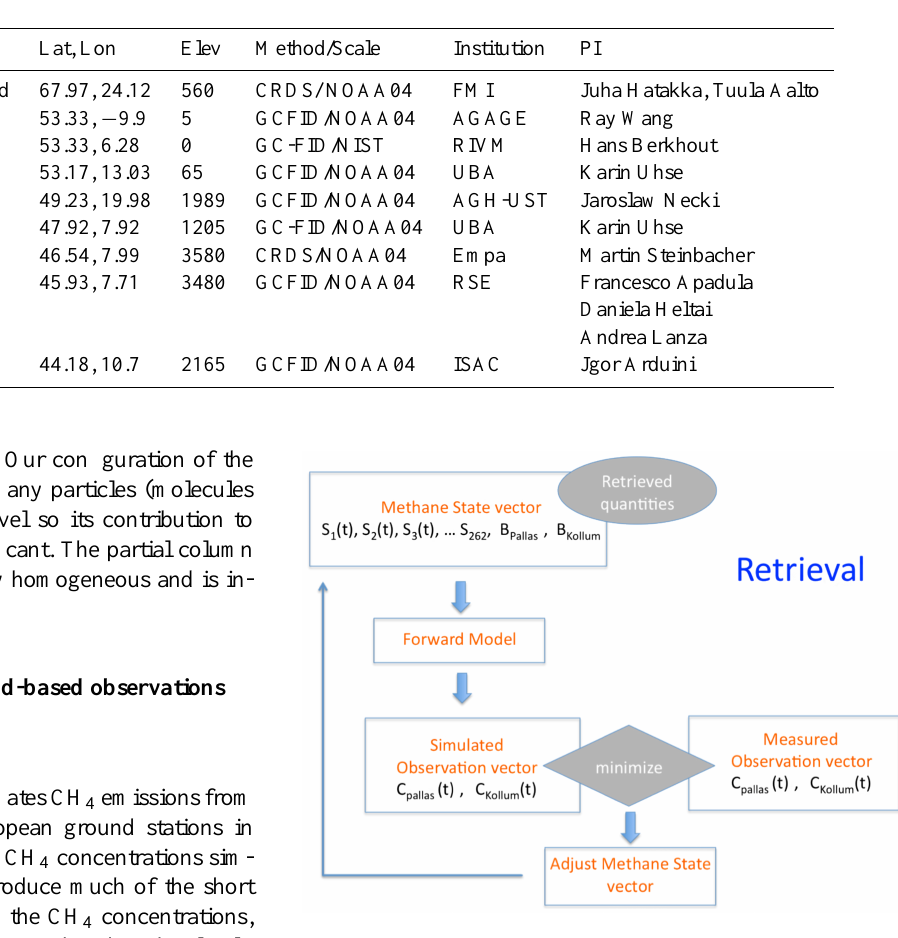
Fig. 3. Schematic of the retrieval algorithm used to obtain source